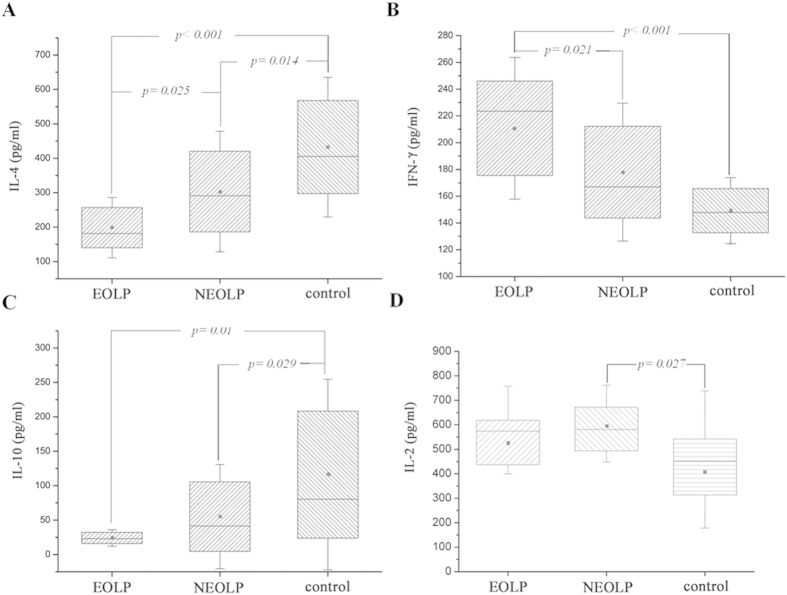
The serum levels of IL-2, IFN-γ, IL-4 and IL-10 in OLP.Kolmogorov-Smirnov test was used to confirm the data to be normal distribution. The significant differences of each cytokine levels between the groups were tested by Student-Newman-Keuls (SNK) test, and results are represented as box plots. Statistical significances are shown in the middle of the lines linking the two compared groups.